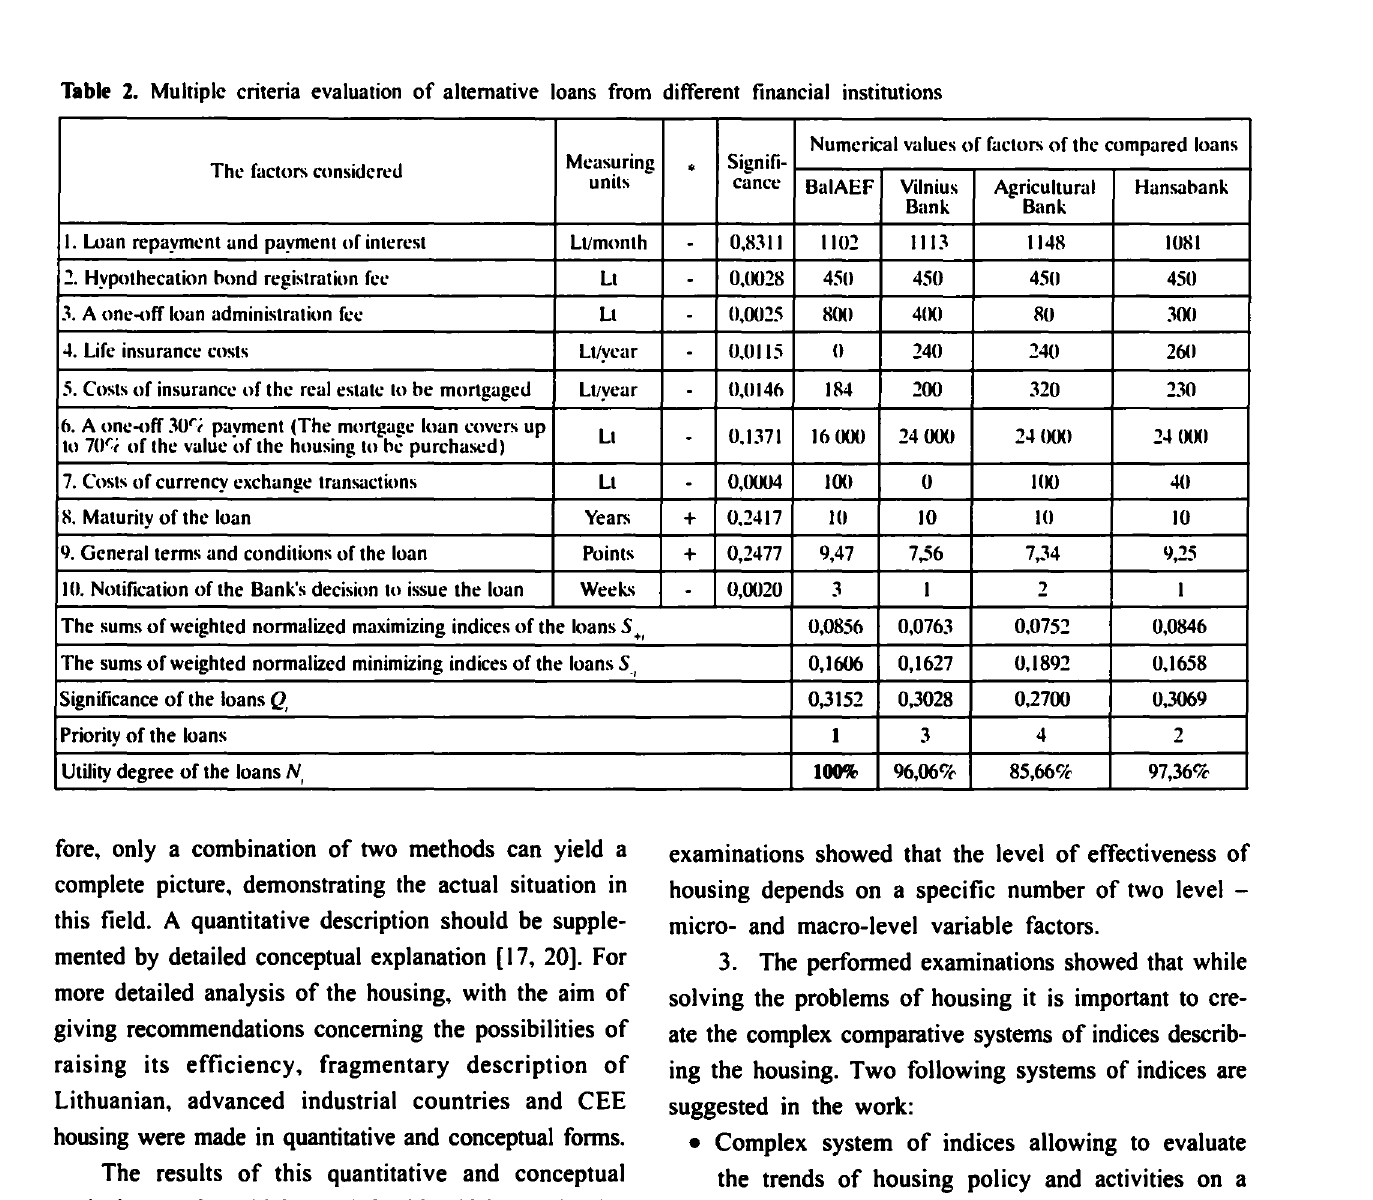
Table 2. Multiple criteria evaluation of alternative loans from different financial institutions